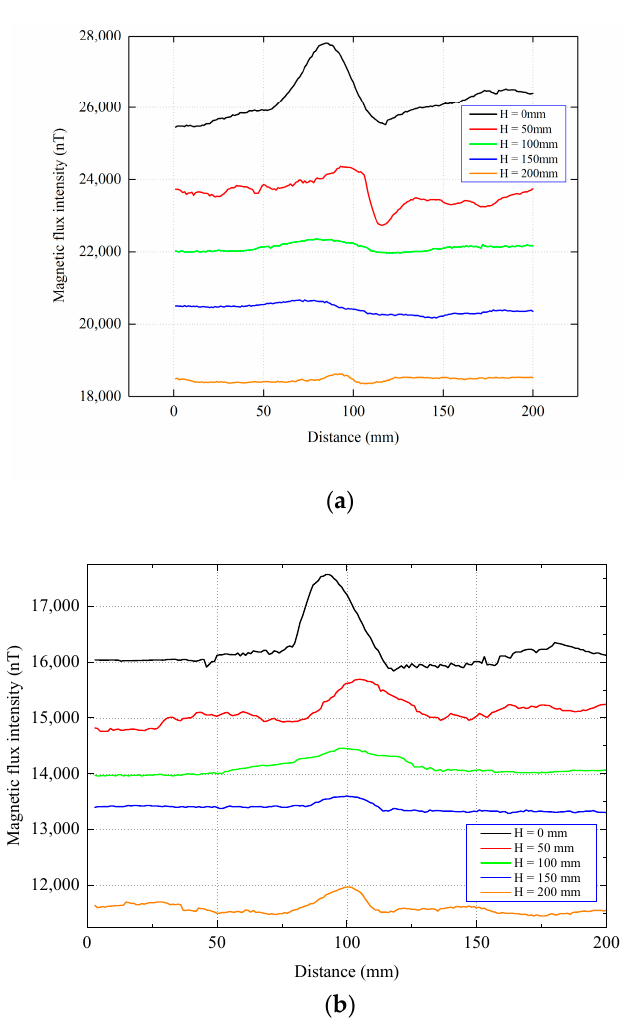
Figure 11. Experimental measurement of the magnetic flux intensity at different lift-offs. ( a ) Tangential component. ( b ) Normal component.